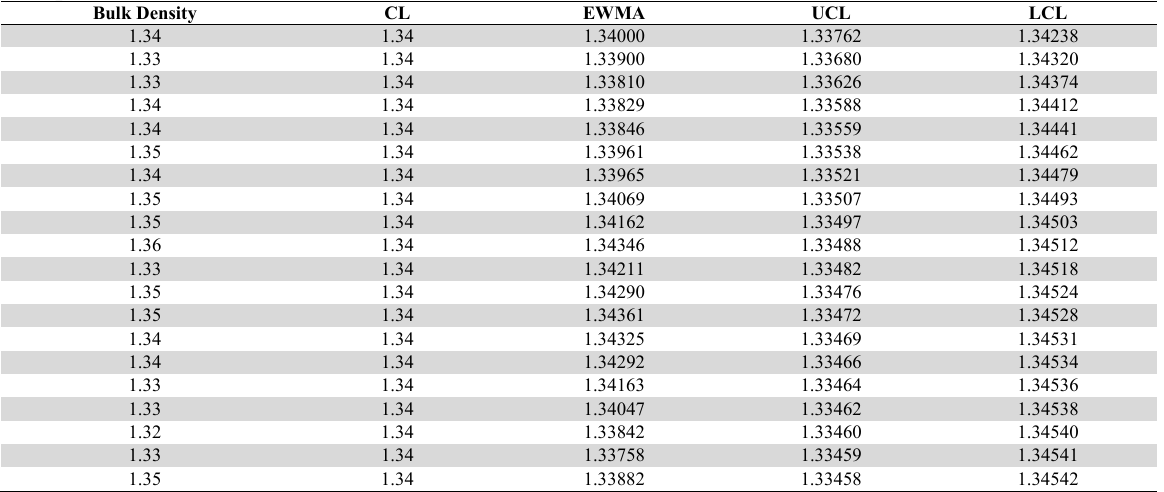
Computation of Control Limits for EWMA